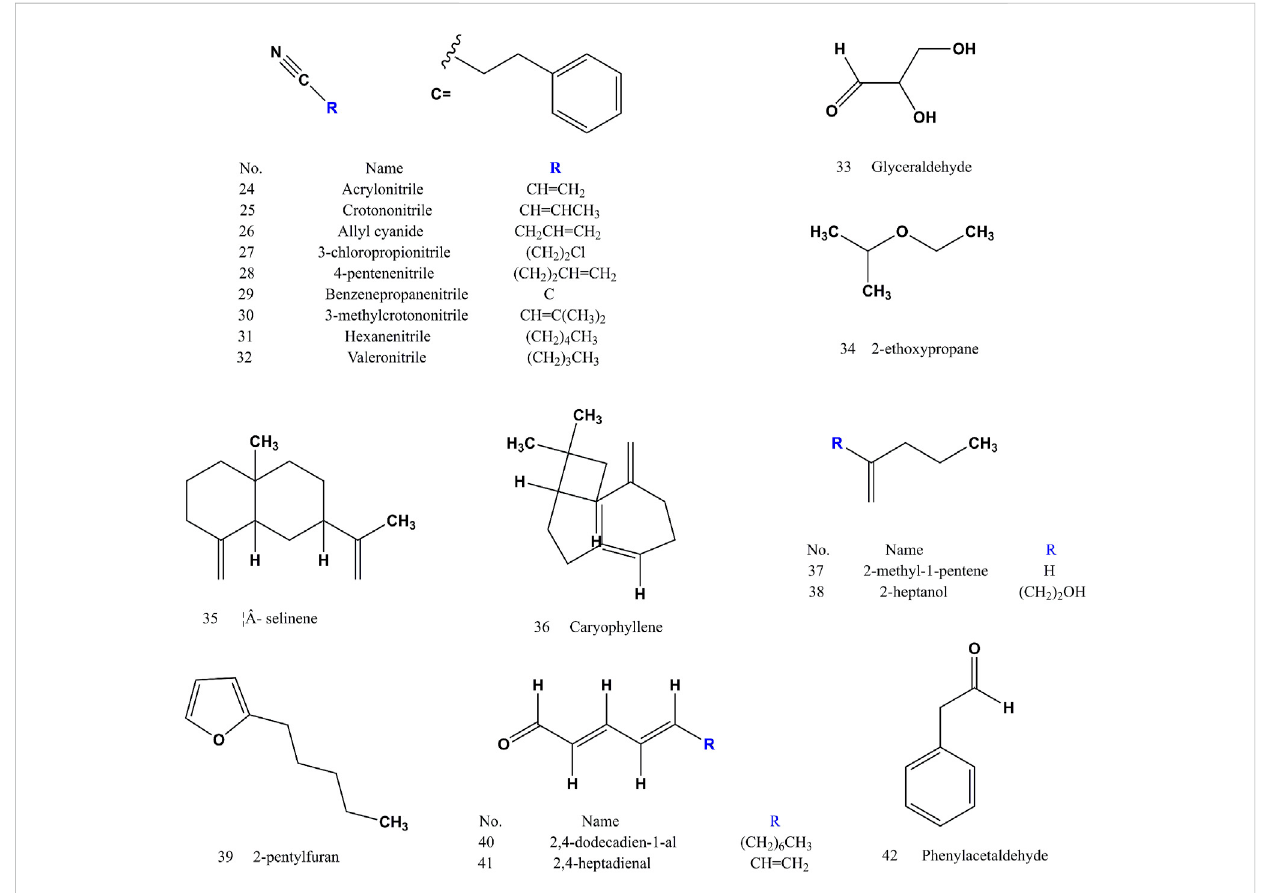
FIGURE 2 Partial chemical structures of volatile oils identi fi ed from SS (compound 24 – 42